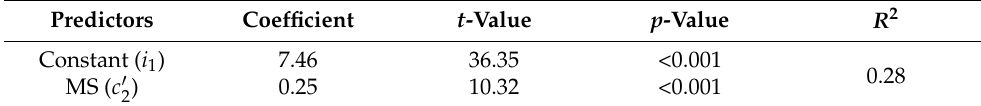
Table 6. The total effect of MS on the SM